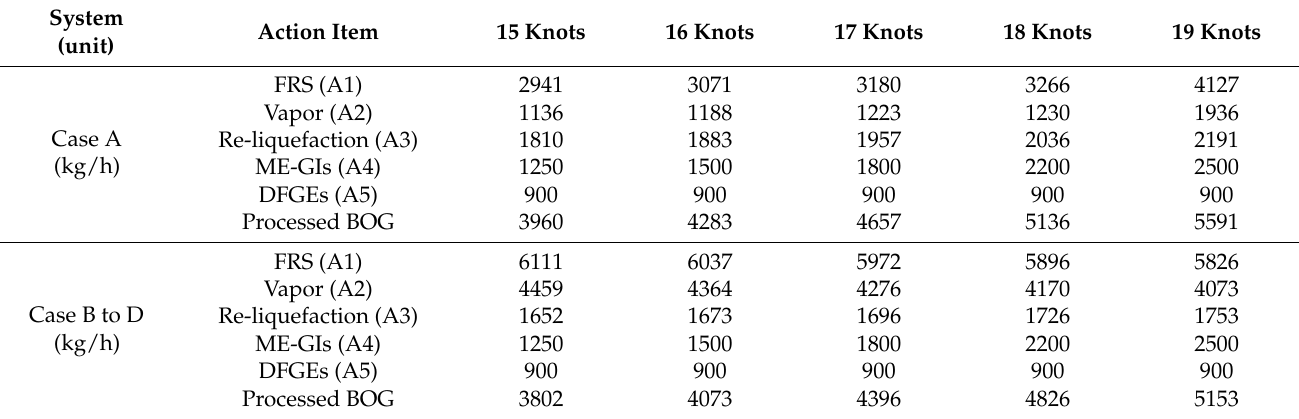
Table 5. Manageable BOG